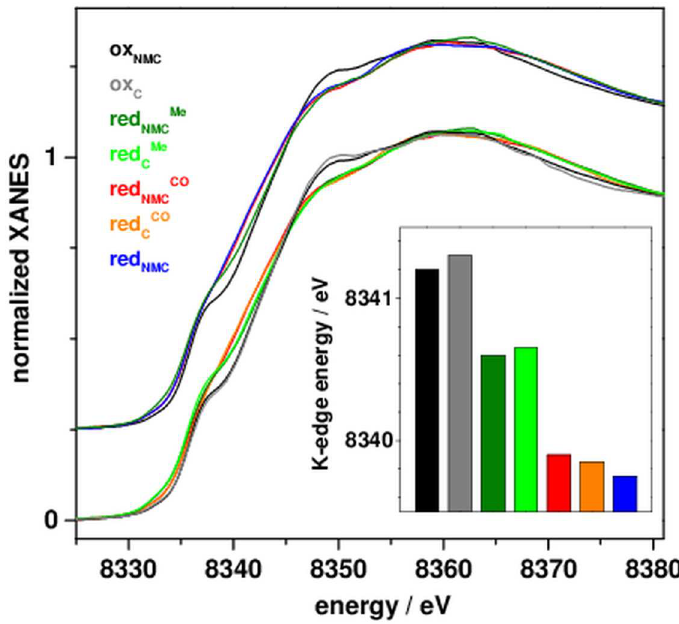
Fig 2. Ni XANES spectra of ACS Ch . Spectra of the indicatedprotein samplesin the main panel were in part vertically displacedfor comparison(dashesmark zero levels), the inset shows respective K-edge energies(at 50% level of normalized X-ray